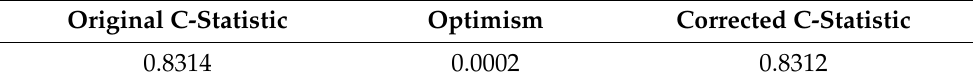
Table 7. Bootstrap-validated C-statistic for the multivariate logistic regression model shown in Table 6. Original